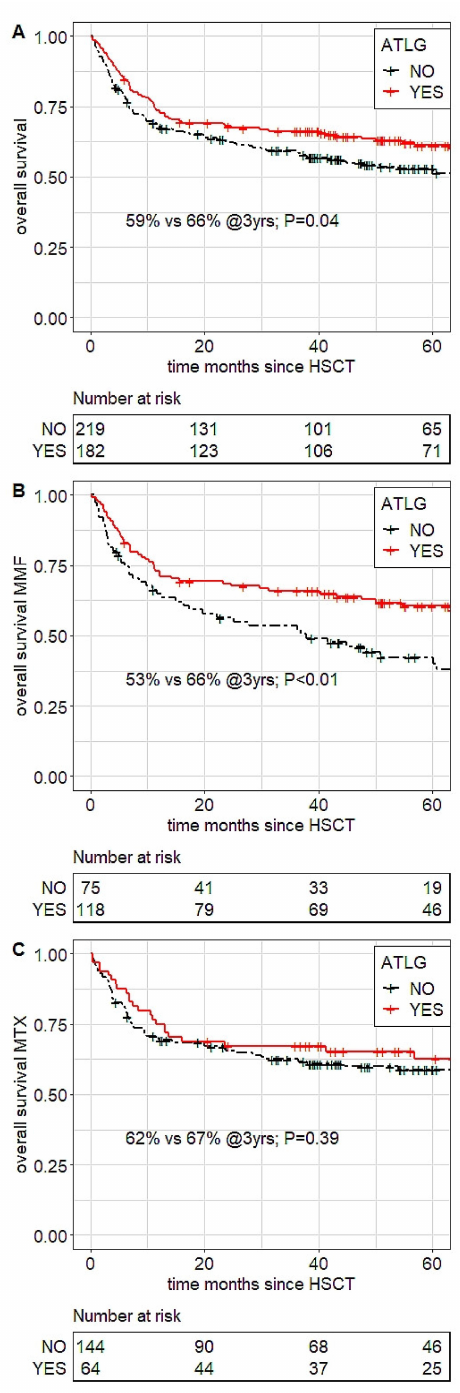
Figure 1. OS by ATLG treatment. Red line, ATLG; black line, no ATLG. ( A ) All HSCT; ( B ) MMF-based HSCT. ( C ) MTX-based